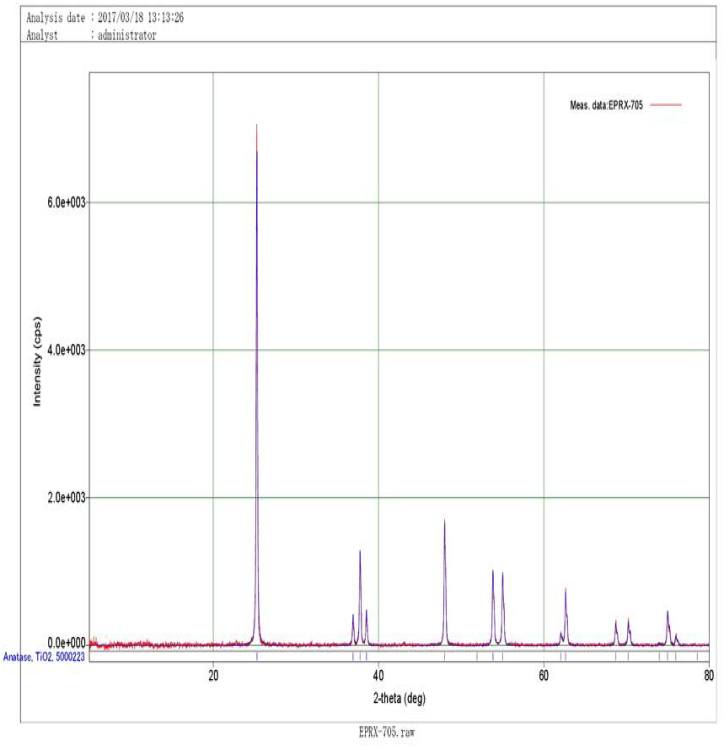
XRD pattern of synthesized TiO2 NPs.